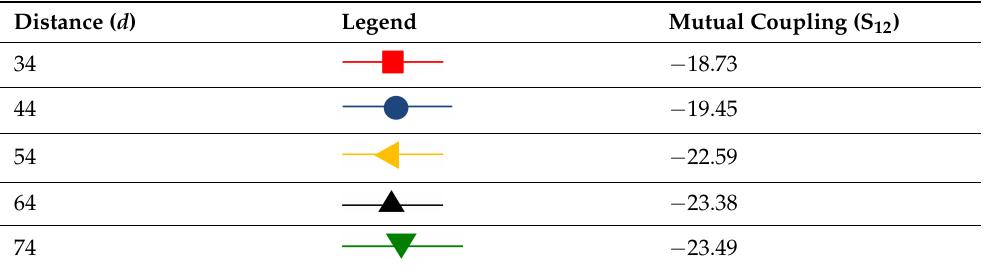
Figure 6. MIMO antenna with MEBG decoupling structure ( a ) front view, ( b ) back view. Table 3. Variation of the MC with the far field distance (mm) for the MIMO UWB antenna arrays when the MEBG decoupling structure is